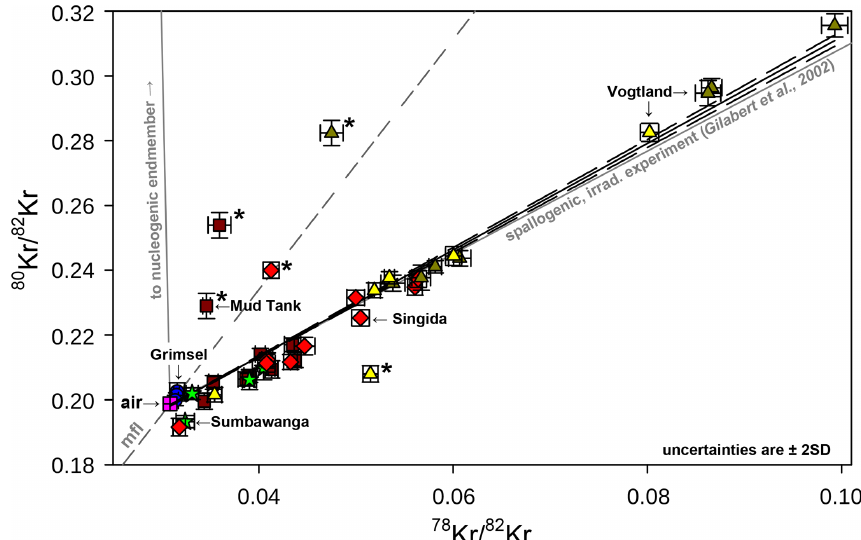
Figure 7. Identification of krypton components and of processes fractionating krypton isotopes. Kr data from zircons of various locations, all of which have been exposed to cosmic rays at or near the Earth’s surface, form a linear trend between air (atmospheric Kr; Aregbe et al., 1996) and a spallogenic endmember. Several samples plot far from this trend (marked with an asterisk ∗ ). They may contain fractionated krypton (“mfl” mass-fractionation line; Kaneoka, 1980) and/or nucleogenic krypton. The linear least square regression of the data (performed with the regression module of SigmaPlot 14) is shown by the solid black line and excludes measurements marked with an asterisk ∗ . The regression is forced through air. The black dashed lines are the 95% confidence intervals of the regression line. Regression of the Kr concentrations from the zircon samples indicates that the terrestrial cosmogenic endmember is slightly different to that obtained from proton-irradiation experiments (solid grey line; Gilabert et al., 2002). Brown squares are Mud Tank carbonatite; red diamonds are for the Singida kimberlite field; green stars are Sumbawanga; blue circles are the Grimsel pass region; triangles represent Vogtland (dark yellow: samples GOEL and VOGT; yellow: samples RBM).